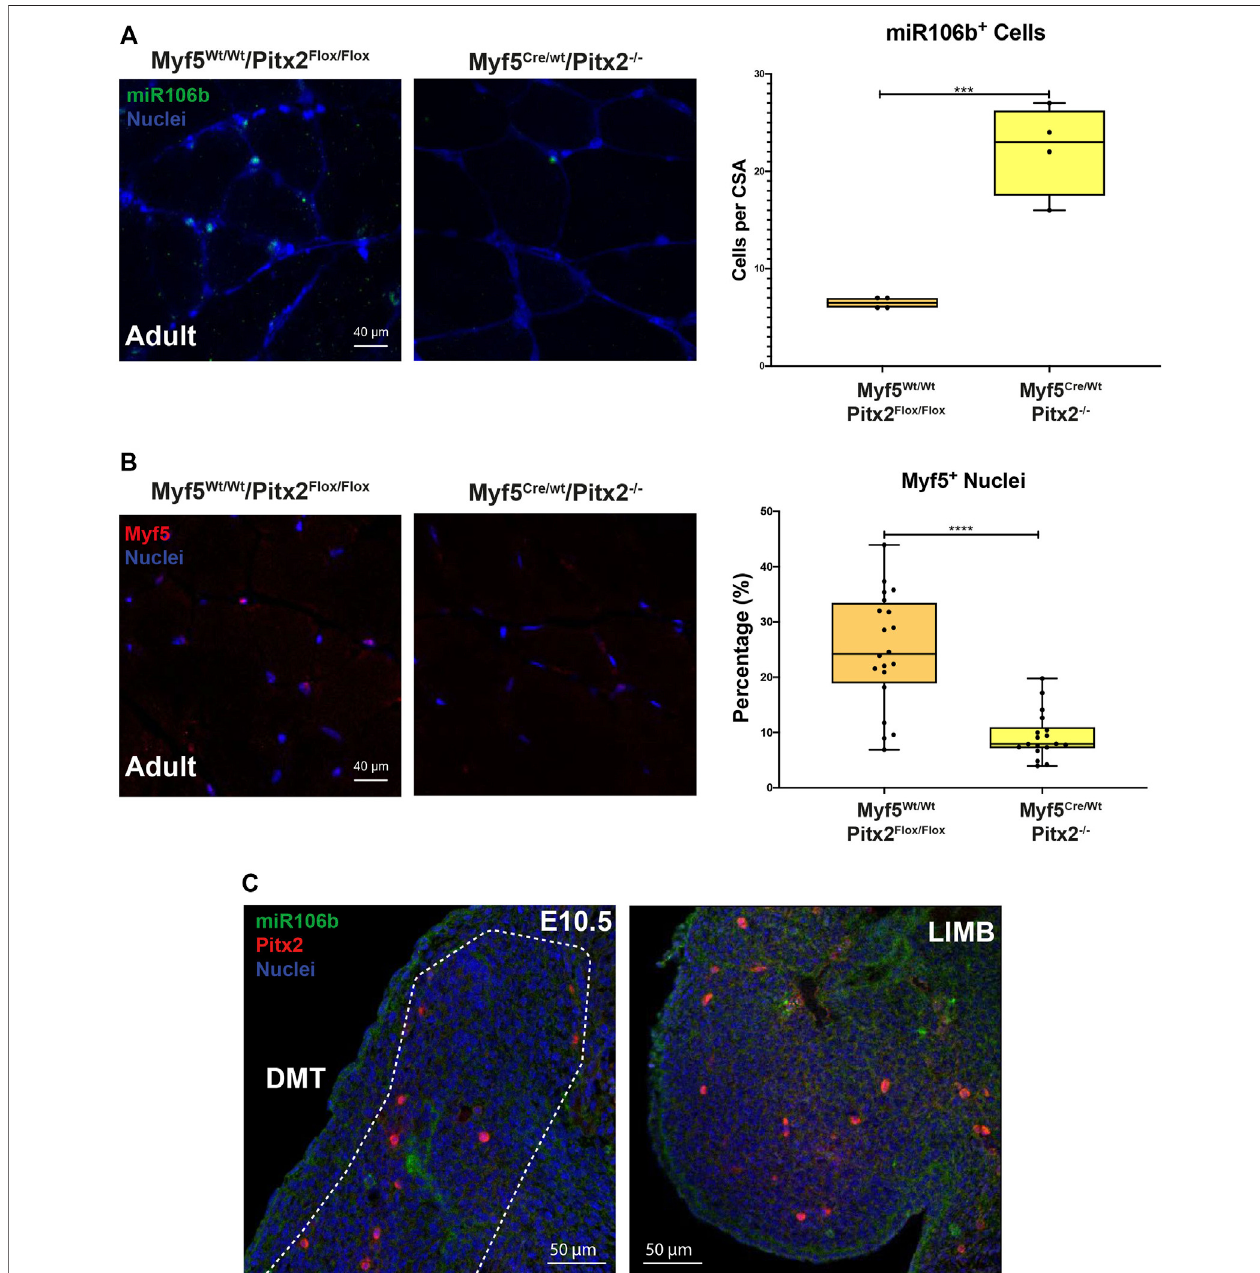
FIGURE 9 | The muscles of Myf5 Cre/Wt Pitx2 − / − mice have high amounts of miR-106b+ cells but lower numbers of Myf5 cells. (A) Representative images of miR- 106b in situ hybridization (FISH) in the TA muscles of Myf5 Cre/Wt /Pitx2 Wt/Wt and Myf5 Cre/Wt /Pitx2 − / − mice and quanti fi cation of miR-106b+ cells. (B) Representative images of MYF5 + cells in the TA muscles of Myf5 Cre/Wt /Pitx2 − / − conditional mutants and quanti fi cation of MYF5+ cells. (C) Representative images of FISH for miR-106b and Pitx2 immunostaining in c57 wild-type embryos at E10.5. *** p < 0.001, **** p < 0.0001 ( n = at least 3 mice per condition).